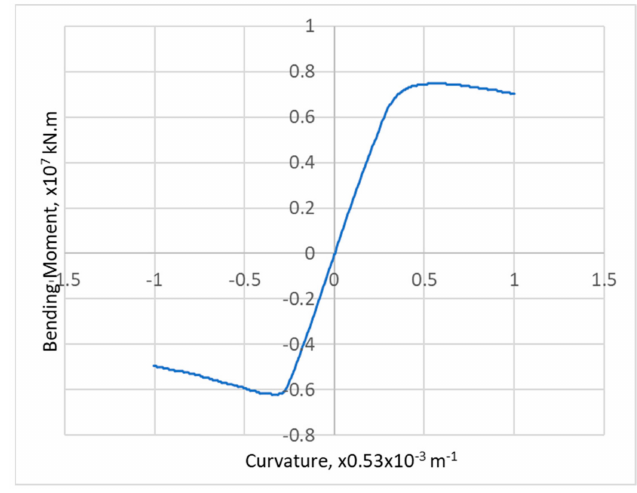
Figure 2. Bending-curvature